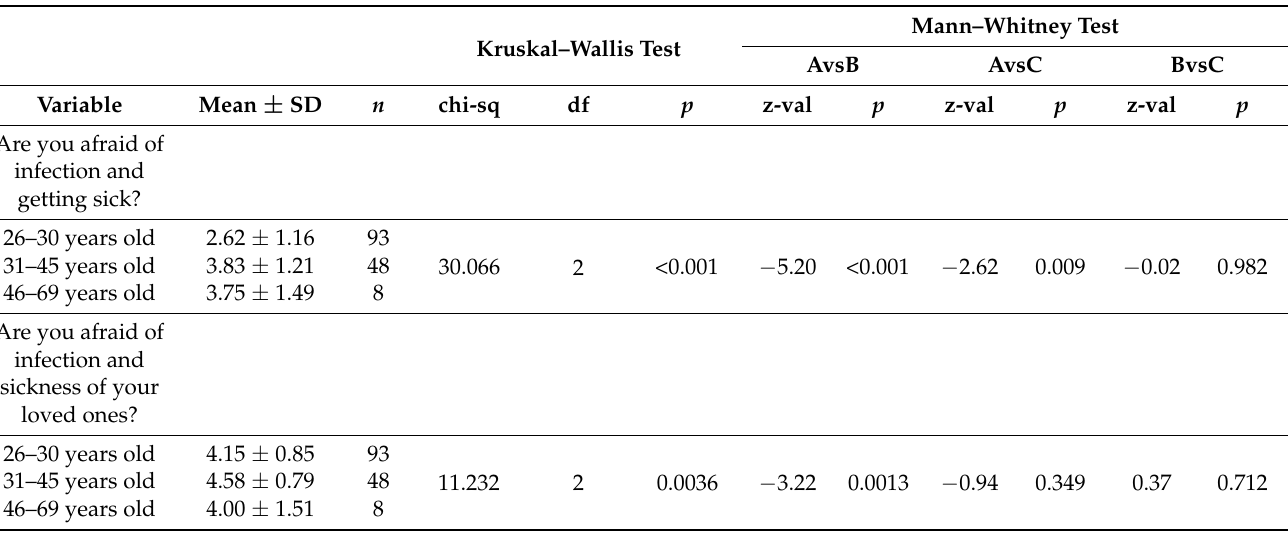
Table 6. Comparison of mean of the afraid of infection and getting sick with age.